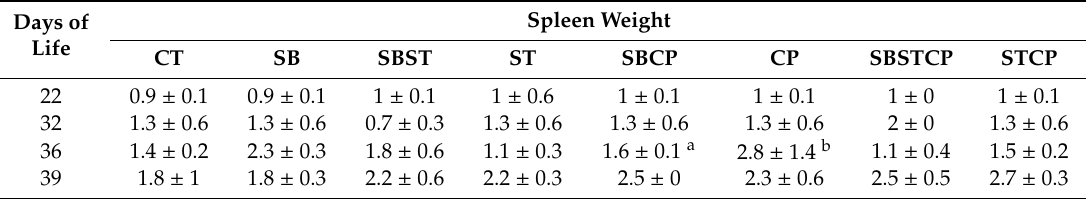
Table 3. E ff ect of dietary supplementation with a synbiotic mix on spleen weight of broilers orally inoculated with Salmonella typhimurium and Clostridium perfringens .